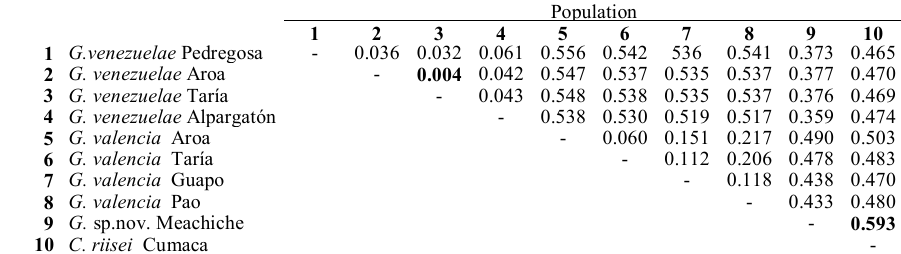
Table 3. Cavalli-Sforza & Edwards (1967) arc distance index for the Gephyrocharax and Corynopoma populations studied.